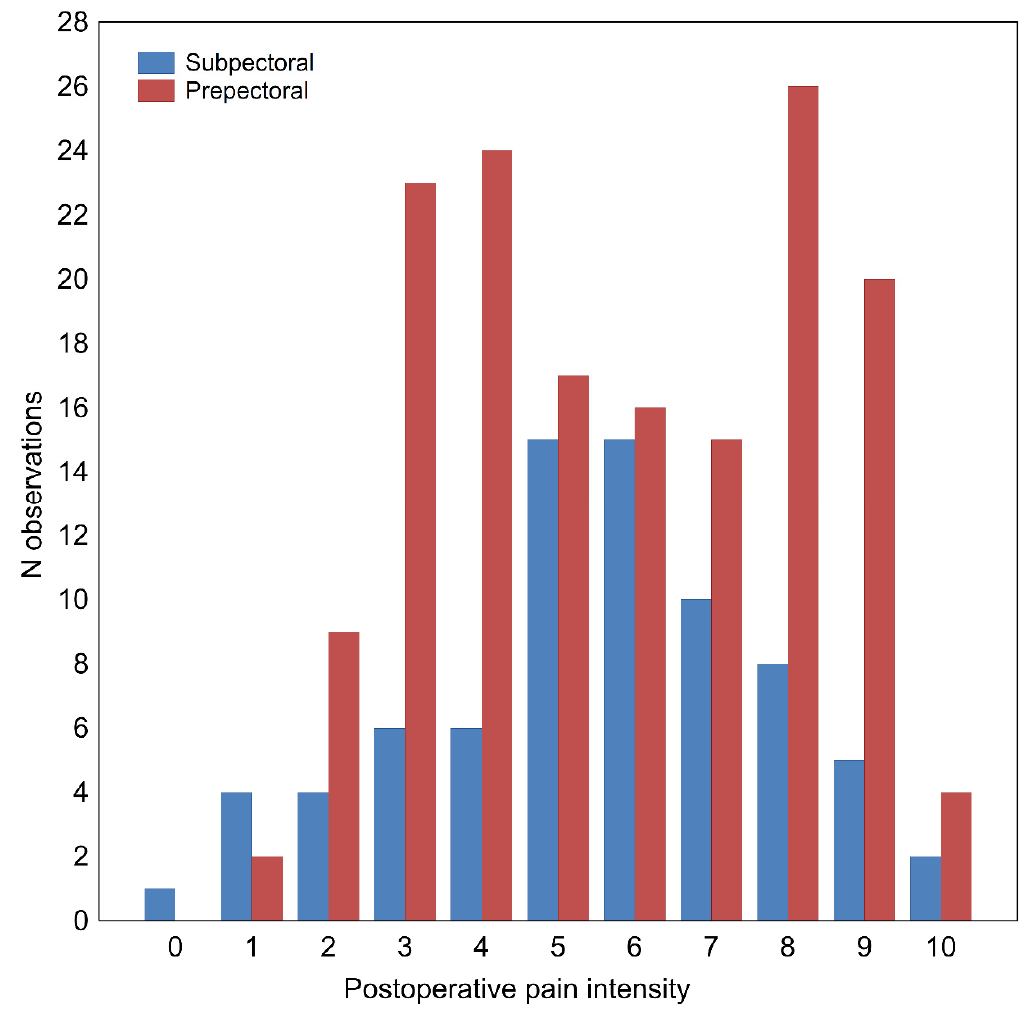
Figure 1. Distribution of postoperative pain intensity on 11-point numeric rating scale in patients undergoing subpectoral or prepectoral breast reconstruction surgery. Postoperative pain intensity, categorized by type of surgery performed (prepectoral vs. subpectoral).